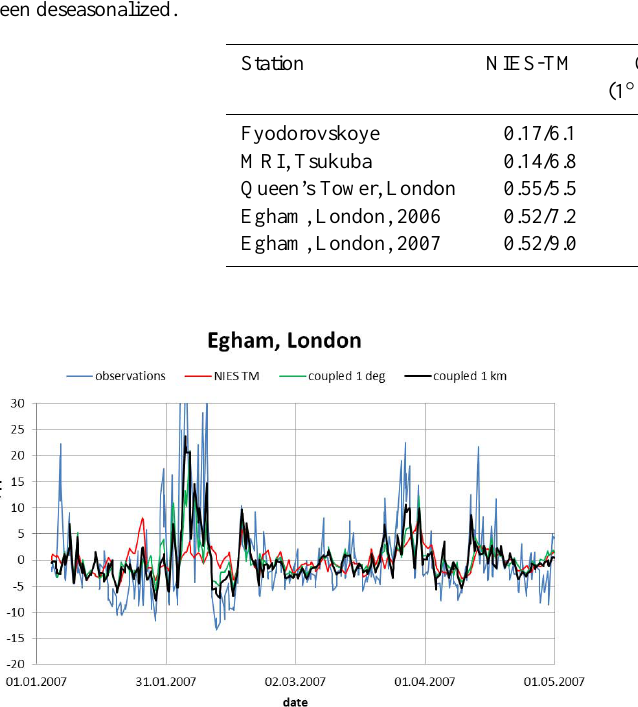
Table 4. Information on correlation coefficients (statistical significance between correlation coefficients (for 1 ◦ : comparison between NIES- TM and 1 ◦ ; for 1km: comparison between 1 ◦ and 1km) and two-tailed p-value between current and previous (from the cell to the left of the current cell in table) correlation coefficients)/centred root-mean-square difference between simulations and observations. The results have been deseasonalized.